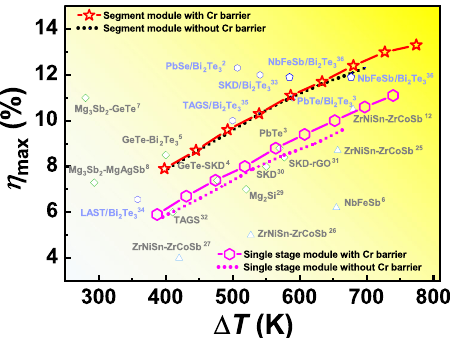
Fig. 1 | Comparison of module ef fi ciencies. Maximum energy conversion ef fi - ciency( η max )versustemperaturedifference( Δ T )fortheHH-basedsingle-stageand segmentedmodules.SomerepresentativeachievementsinothernovelTEmodules are also illustrated for comparison, including the single-stage models of half- Heusler 6,12,29,37 – 39 , Mg 2 Si 40 , skutterudite (SKD) 41,42 , Pb – Te based 3 , Ge – Te based 4,5,43 , Mg 3 Sb 2 7,8 , and various segmented modules of PbSe/Bi 2 Te 3 2 , PbTe/Bi 2 Te 3 3 , SKD/ Bi 2 Te 3 34 , LAST/Bi 2 Te 3 44 , TAGS/Bi 2 Te 3 45 and HH/Bi 2 Te 3 46 . The published data of these modules are summarized in Table